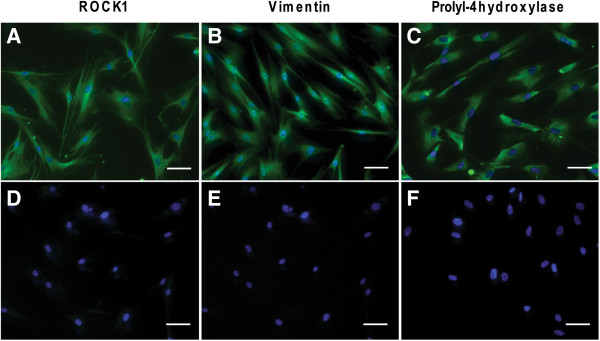
Immunostaining of fibroblasts from COPD patients. Isolated fibroblasts from control subjects and COPD patients were immunostained to verify their expression of ROCK1 (A) and the mesenchymal markers Vimentin (B) and Prolyl-4 hydroxylase (C). The control stainings in the absence of primary antibodies for ROCK1 are shown in (D), for vimentin in (E) and for prolyl-4 hydroxylase in (F). Scale bars represent 50 μm.